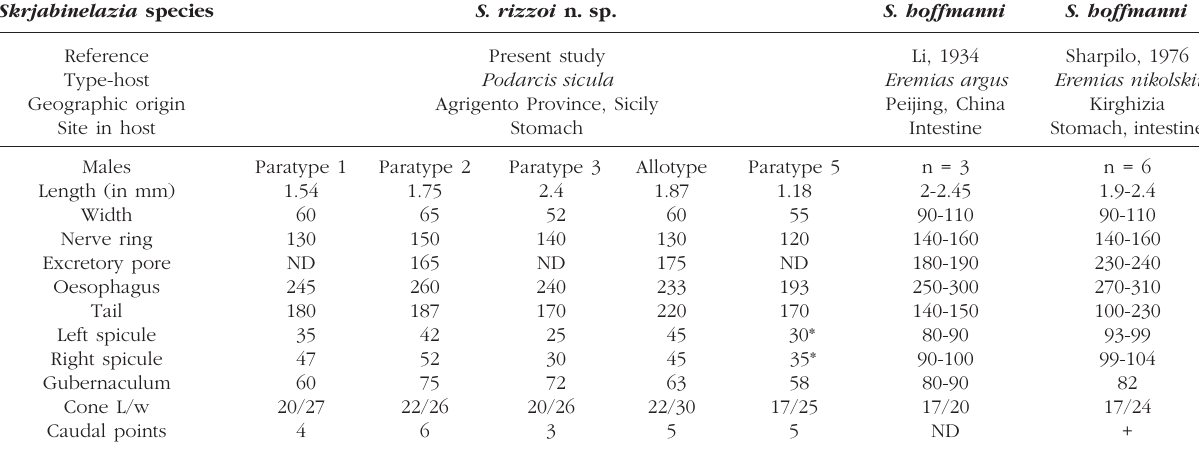
Table II. – Male measurements of S. rizzoi n. sp., S. hoffmanni Li, 1934, S. hoffmanni sensu Sharpilo,